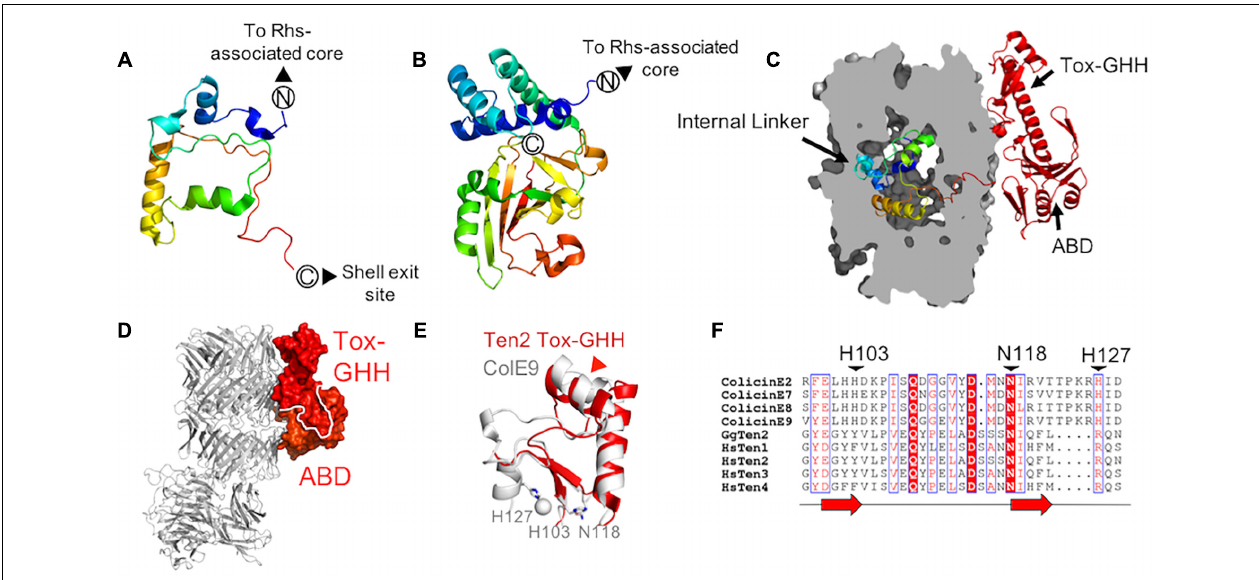
FIGURE 3 | Teneurin domains downstream of the central scaffold region (A,B) The chicken Ten2 internal linker (A) as compared to the crystal structure of the cytotoxic C-terminal region of a Y. entomophaga C-protein (Busby et al., in preparation; PDB 6AQK) (B) . Both are colored from N- to C-terminus according to the rainbow. (C) The chicken Ten2 internal linker domain is shown as ribbons inside a clipped surface representation of the Ten2 YD-shell (gray). The ABD and Tox-GHH are shown as red ribbons. (D) The Ten2 ABD and Tox-GHH domain are shown in surface representation and colored as in Figure 1A . The rest of the protein is shown as gray ribbons, oriented as in Figure 1A . (E) Structural alignment of the Ten2 Tox-GHH domain (red ribbon) and the nuclease domain of colicin E9 (white ribbon, PDB 1BXI). Side chains of the catalytically important residues and ions in colicin E9 are shown as sticks and spheres, respectively. The position of the predicted TCAP proteolysis site in Ten2 is indicated with a red arrowhead. (F) Structure-based sequence alignment of the Escherichia coli DNase colicins, all four human teneurin paralogs and chicken Ten2. Black arrowheads indicate the catalytically important residues of the colicins. Each red arrow corresponds to one β